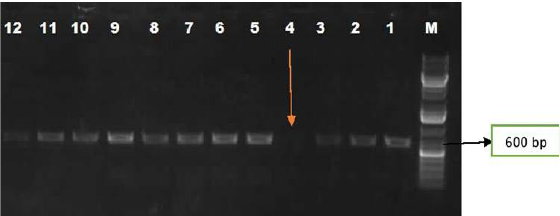
Fig. 5. Gel image of ndhF primer amplified Inula gDNA’s b y Phenol Choroform Isoamyl Alcohol Protocol 1. I. anatolica , 2.